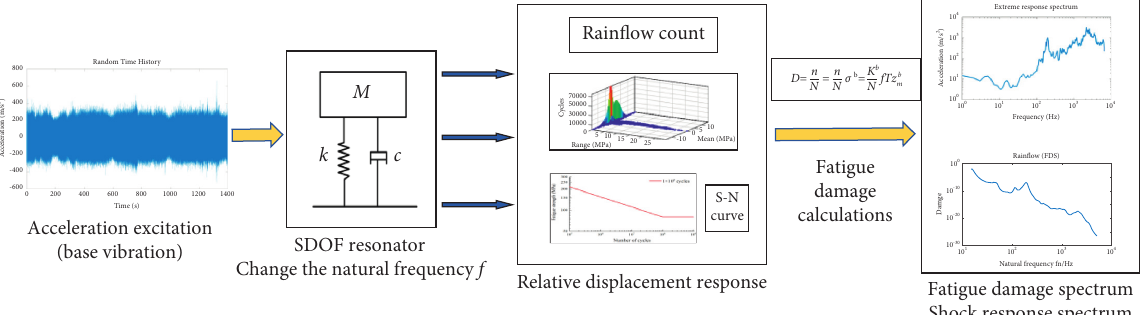
Figure 3: Flow chart of fatigue damage spectrum calculation method under non-Gaussian excitation.